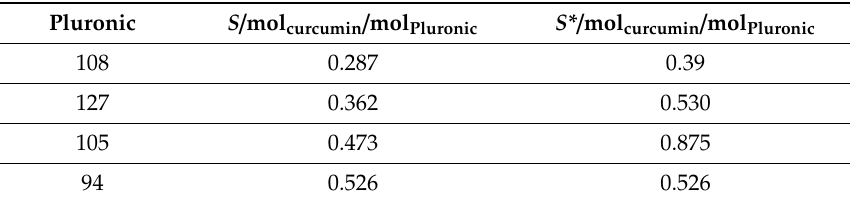
Table 3. Solubilization capacity in the linear range ( S ) and at Pluronic concentration of11mM ( S* ) determined for curcuminsolubilization in Pluronicmicellar systems at 37 ± 0.5 ◦